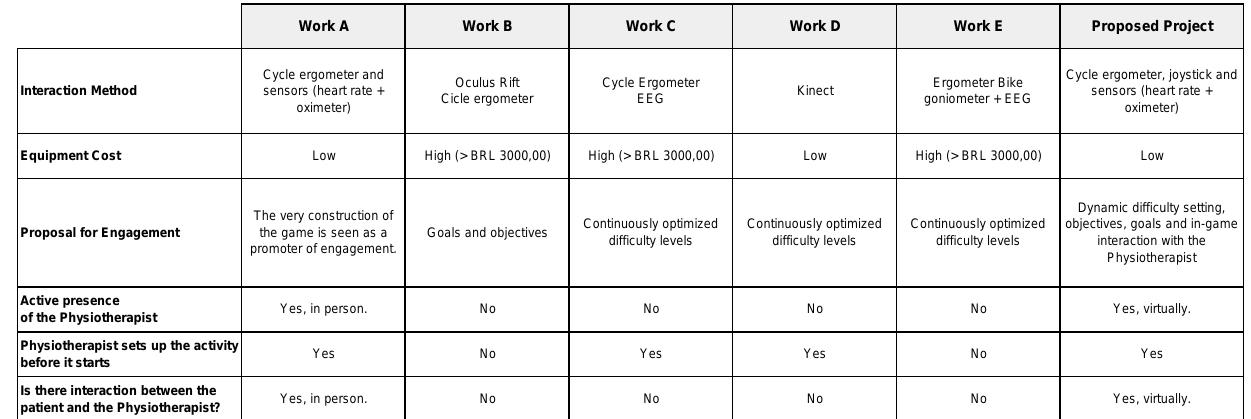
Table 1. Related works and the proposed approach.